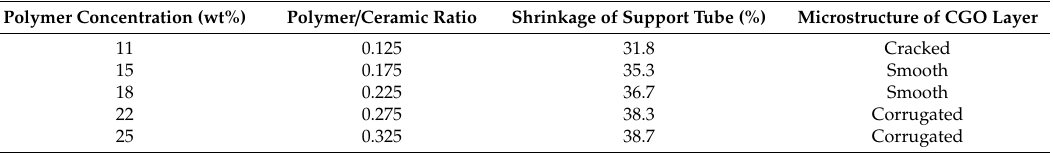
Table 2. Shrinkage comparison of the support tubes fabricated from slurries with different polymer concentrations. Shrinkage comparison of the support tubes fabricated from slurries with di ff erent polymer concentrations.